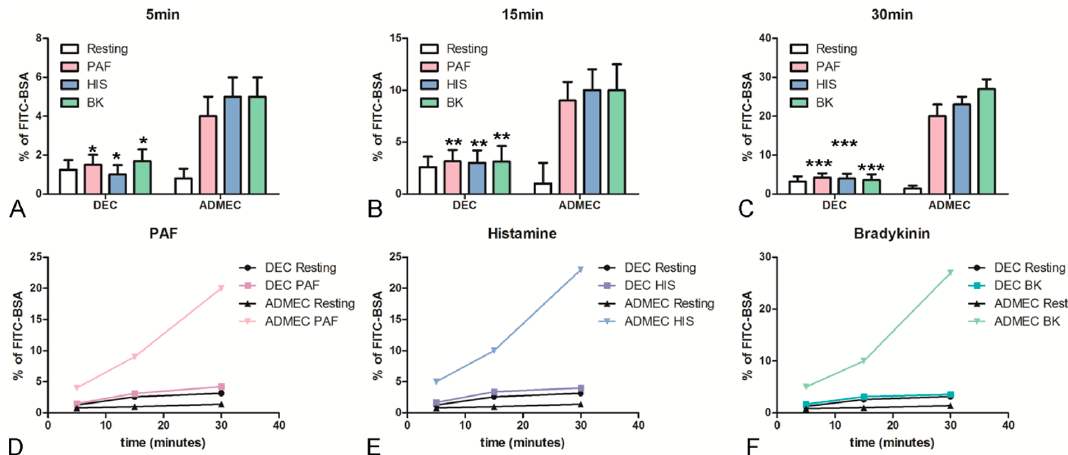
Figure 2. Permeabilizing activity of endothelial cells to classical vasoactive stimuli. The permeabilizing activity was evaluated kinetically, after 5 ( A ), 15 ( B ) and 30 min ( C ) adding PAF ( D ), HIS ( E ) or BK ( F ), to the upper chamber of the TW, measuring the amount of FITC-labeled BSA that leaked through a monolayer of endothelial cells into the lower chamber. The data represent the mean ± SD of duplicate samples from four separate experiments * p < 0.05; ** p <0.01; *** p <0.005.